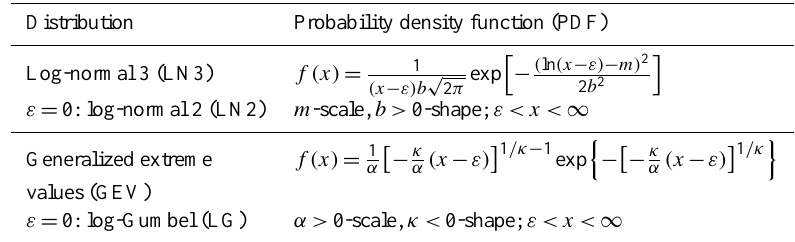
Table 2. Probability density functions of log-normal and GEV